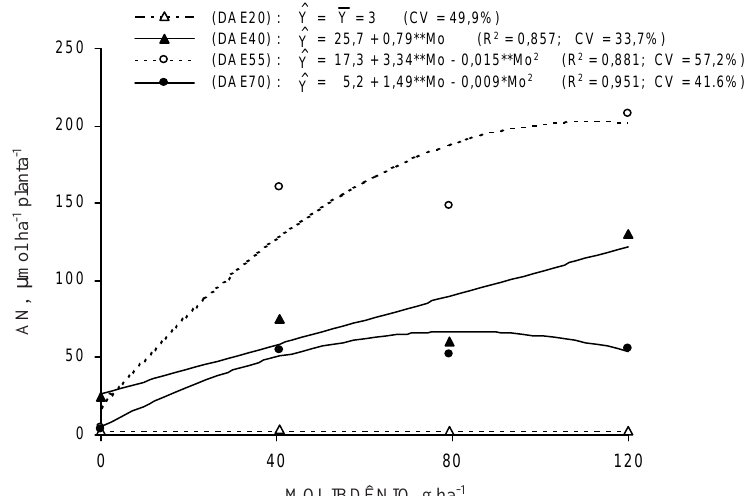
Figura 1. Atividade da enzima nitrogenase (AN) aos 20, 40, 55 e 70 dias da emergência (DAE) do feijoeiro cv. Ouro Negro, considerando a aplicação foliar de molibdênio. *, ** significativos, respectivamente, a 5 e a 1% pelo teste